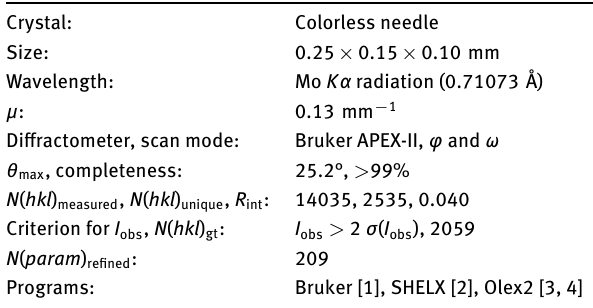
Table 1: Data collection and handling.